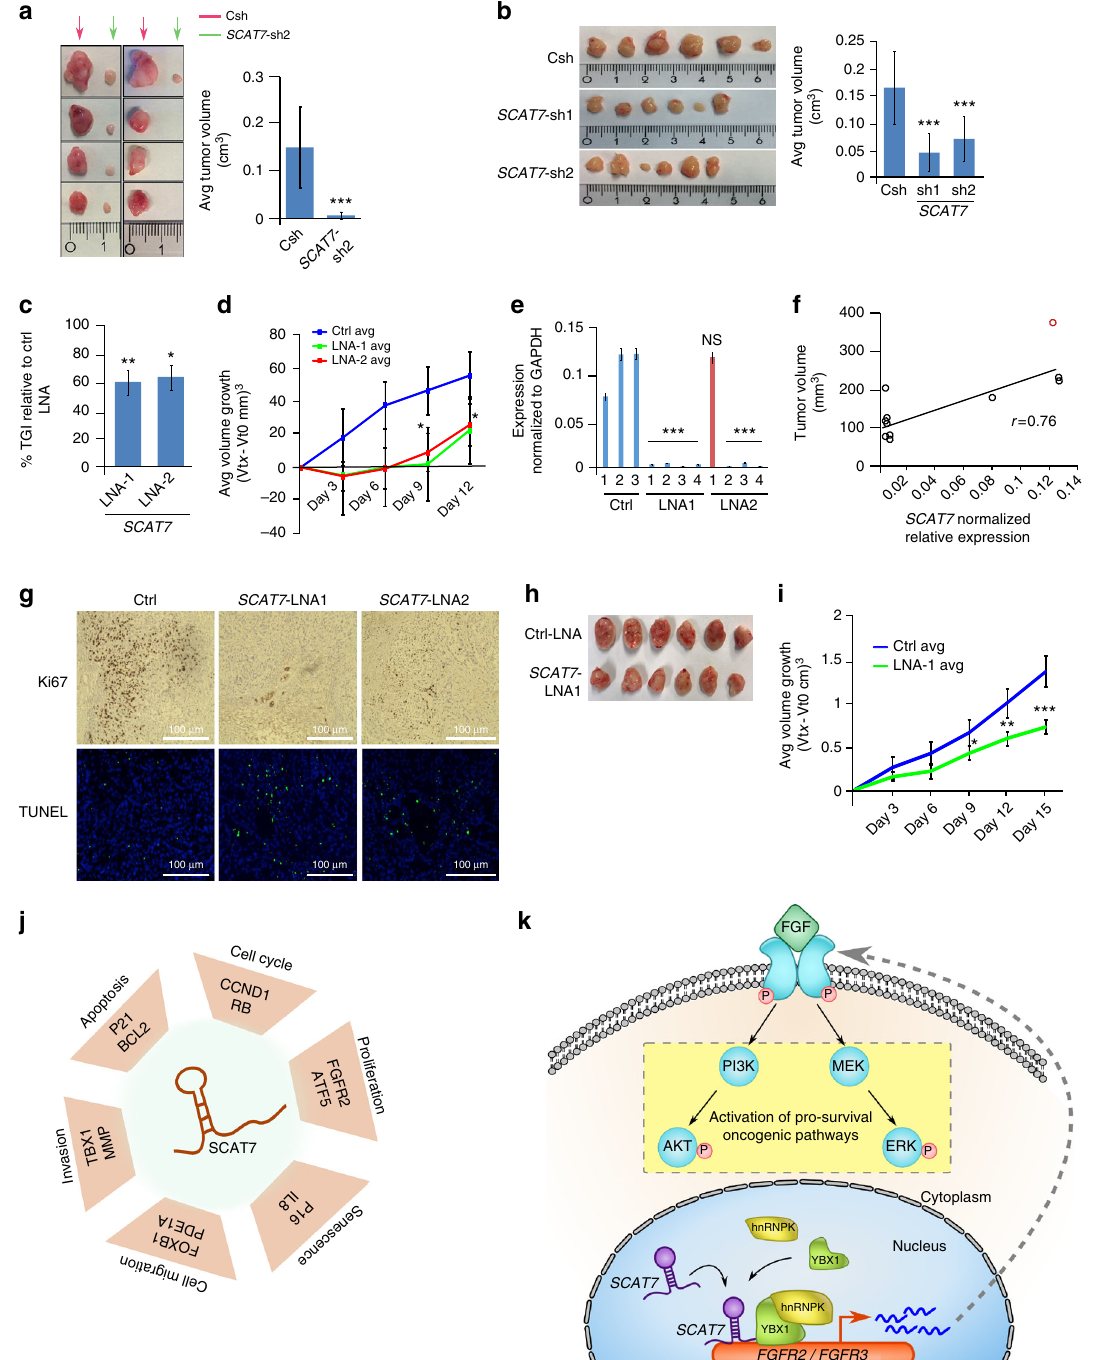
Clinical investigation of S-phase lncRNAs in TCGA tumors . For clinical investigations, we have chosen 1145 lncRNAs that were showing signi fi cant tem- poral expression in EtU-labeled samples. The selected lncRNAs were dichotomized with respect to the expression cut-off based on either mean, median, or quartiles and considered whichever gave the best discrimination. Thereafter, overall survival rate in patients above and below the selected cut-off levels, was calculated according to the KM method, and the log-rank test was used to assess differences in